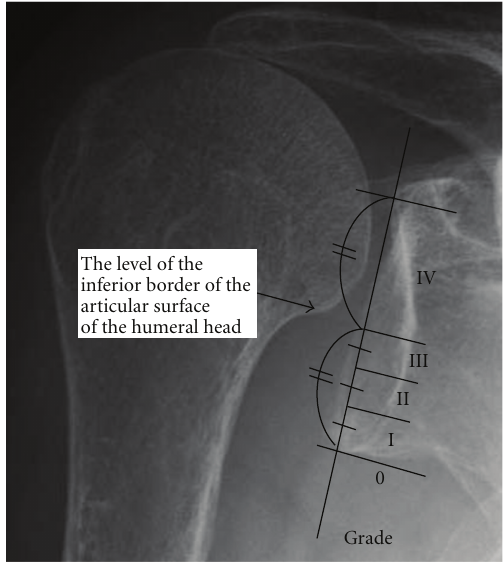
Figure 1: Oizumi classification. Grading of upper migration of hu- meral head. The inferior half of the glenoid is divided into 3 zones. The grade is defined by the position of the inferior border of the articular surface of the humeral head in the following zones: grade 0, the inferior border of the articular surface of the humeral head is below the lower glenoid rim; grades I, II, and III, the inferior border of the articular surface of the humeral head is in each zone; grade IV, the inferior border of the articular surface of the humeral head is above zone III.